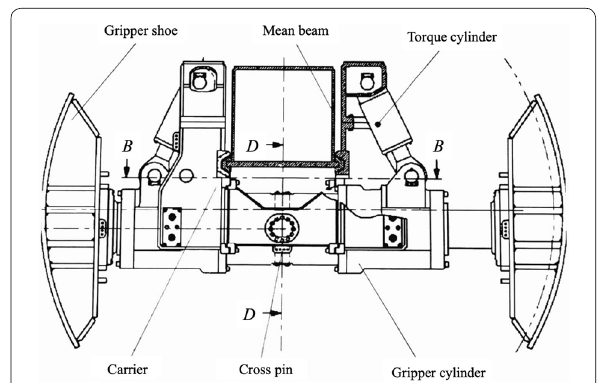
Figure 2 Structure of gripper carrier